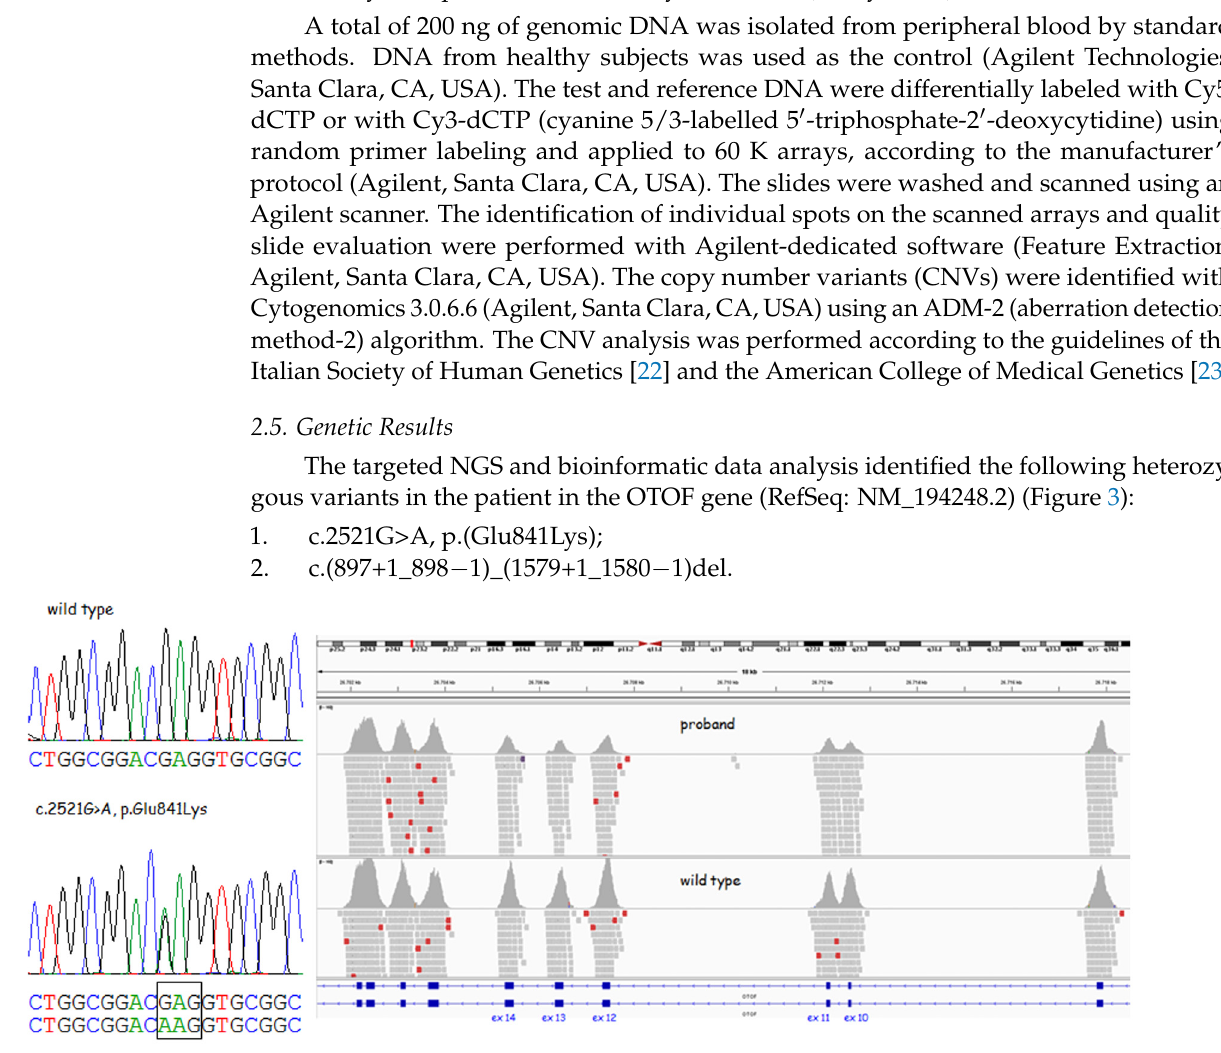
Figure 3. Variants in the OTOF gene in the proband. On the left are the electropherograms showing the wild-type sequence and the heterozygous missense variant (c.2521G>A). On the right are the IGV alignments showing a halved coverage from exon 10 to 14, indicating a genomic deletion (GRCh37/hg19; RefSeq: NM_194248.2). Reads that are colored red have larger than expected inferred sizes, and therefore indicate possible deletions. However, red reads are randomly present also in the wild-type control, so taken per se they have no clinical significance. Blue rectangles represent exons, connected by blue lines which represent introns.